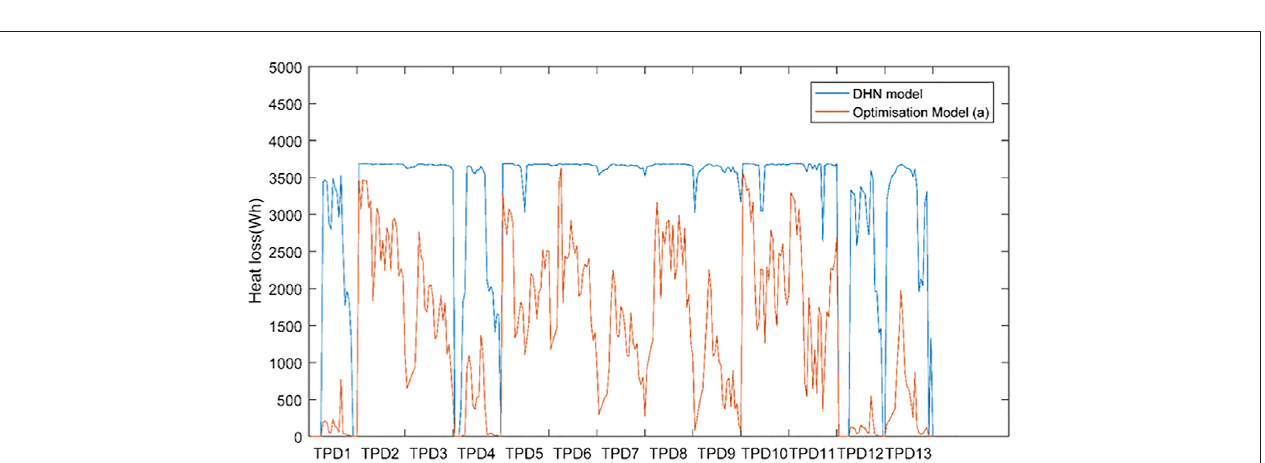
FIGURE 7 | hourly network heat loss for typical days (TPD).